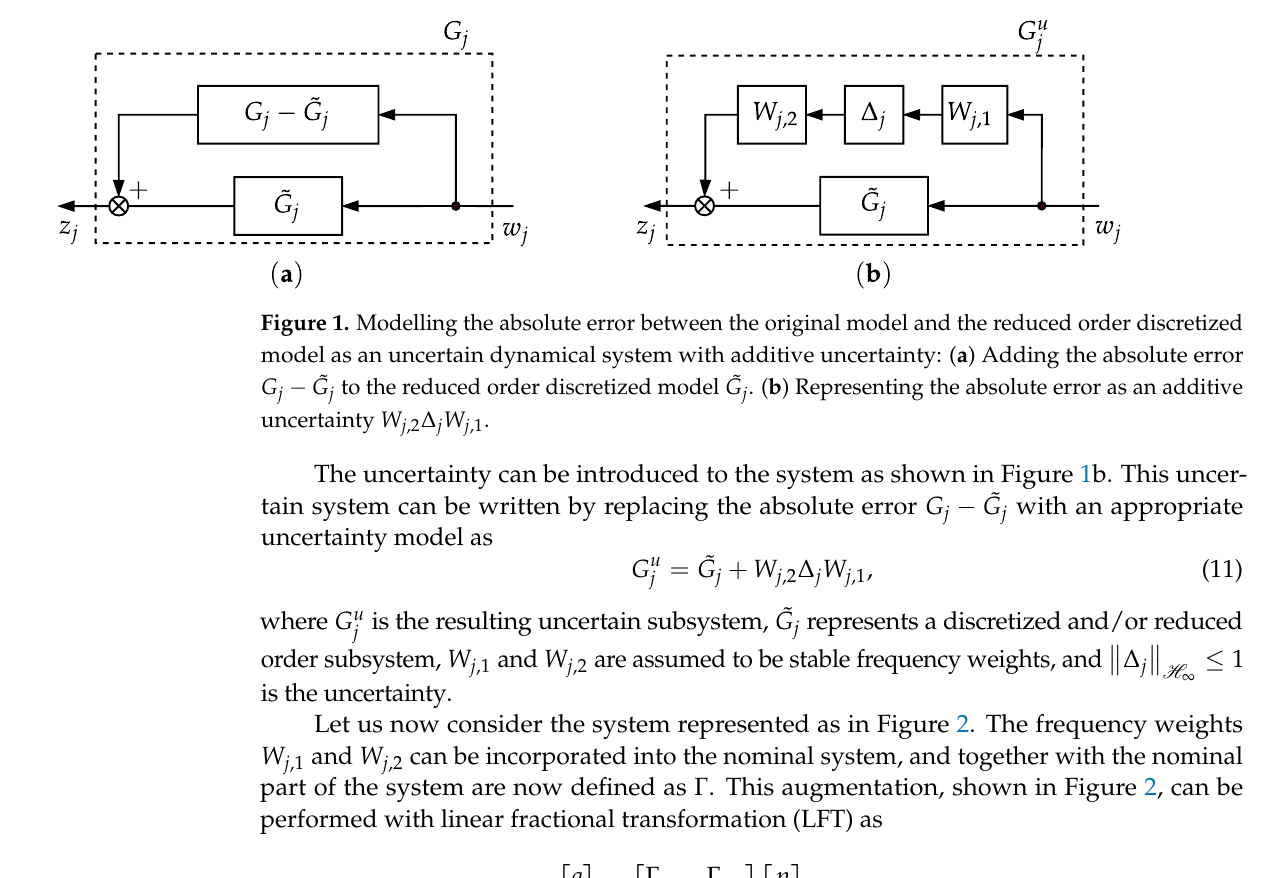
˜ G j . ( b ) Representing the absolute error as an additive